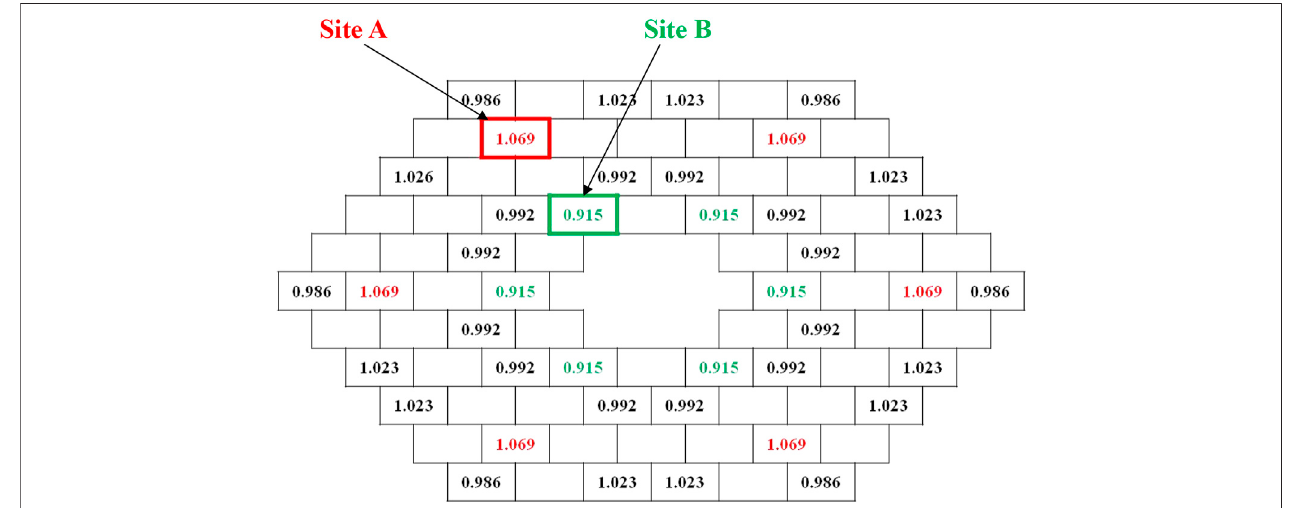
FIGURE 11 | Relative power distribution of S-CO 2 assembly using arrangement B (BOL).